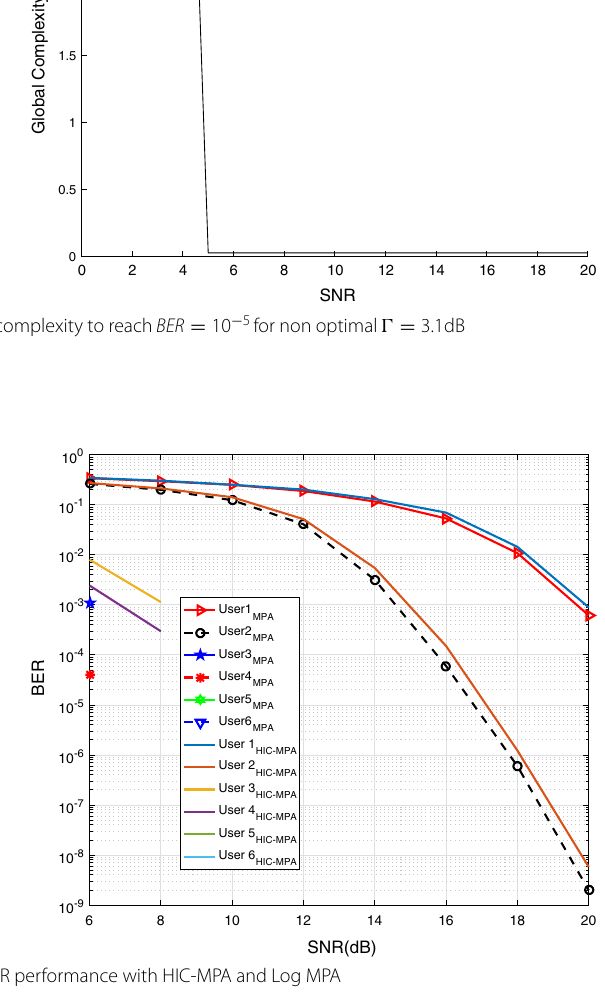
Fig. 15 The BER performance with HIC-MPA and Log